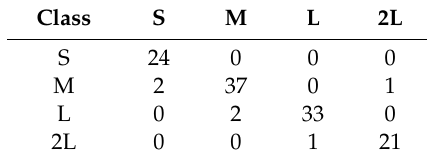
Table 4. Confusion matrix of mass prediction through an estimated volume.